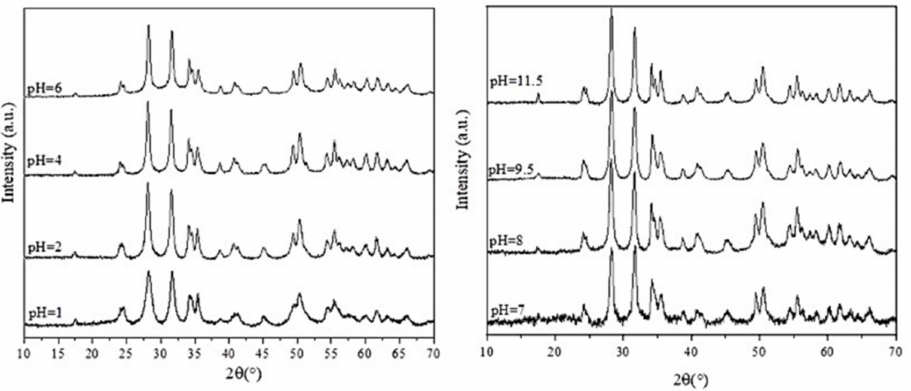
Figure 7. Powder X-ray diffraction patterns of HfO 2-NPs prepared by hydrothermal synthesis at 180 ◦ C and pH 1–11.5 for 6